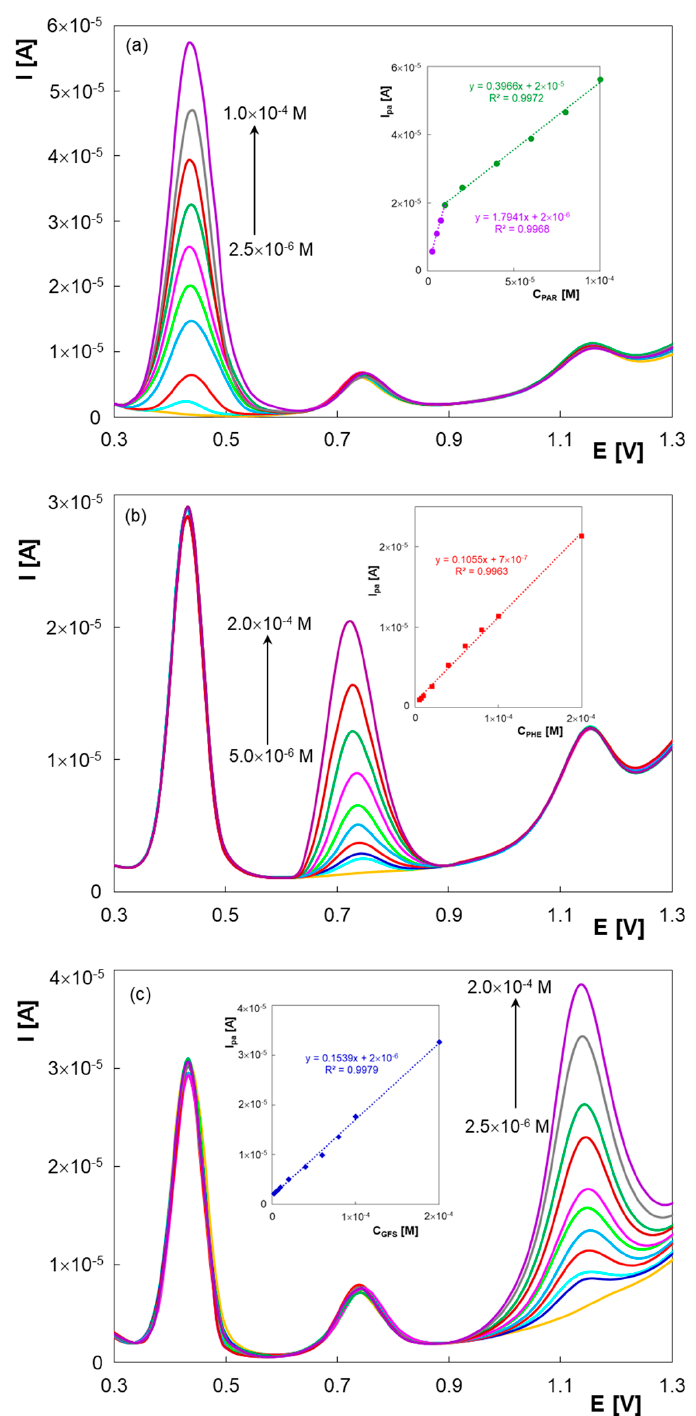
Figure 4. Differential pulse voltammograms of PHE, GFS (2.00 × 10 − 5 M each) and different PAR concentrations ( a ), PAR, GFS (2.00 × 10 − 5 M each) and different PHE concentrations ( b ) and PAR, PHE (2.00 × 10 − 5 M each) and different GFS concentrations ( c ) at PGE* in BR buffer solutions pH 6.00. The linear ranges for PHE and GFS were 5.00 × 10 − 6 M–2.00 × 10 − 4 M (I pa_PHE [A] = 0.1055 × C PHE [M] + 6.97 × 10 − 7 , R 2 = 0.9963) and 2.50 × 10 − 6 M–2.00 × 10 − 4 M (I pa_GFS [A] = 0.1539 × C GFS [M] + 1.67 × 10 − 6 , R 2 = 0.9979), respectively (Figure 4b,c). The limits of detection (LOD) and quantification (LOQ) of PAR, PHE and GFS were calculated from each linear calibration curve as 3.3 and 10 times, respectively, the ratio between intercept standard deviation and slope of the regression line of the target analyte.